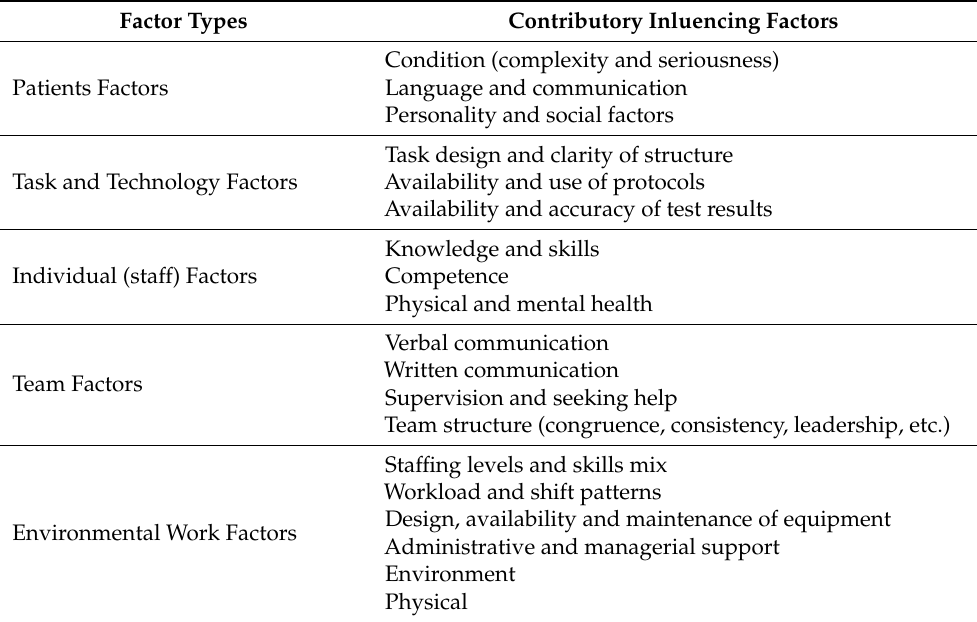
Table 2. Framework for the analysis of contributory factors according to the London